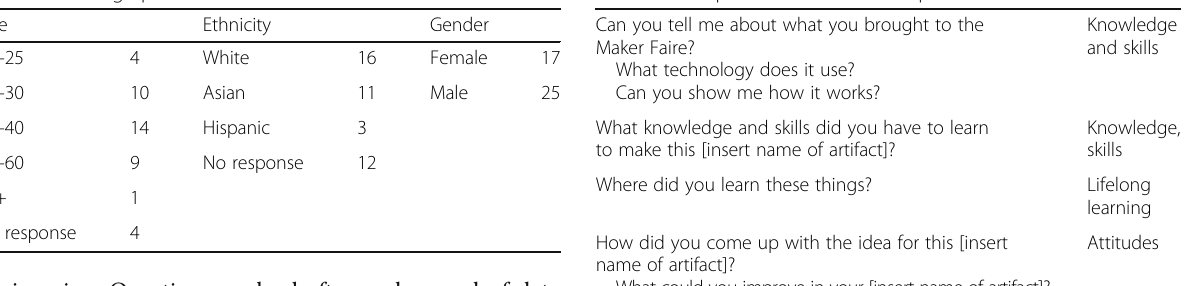
Table 6 Sample artifact elicitation questions